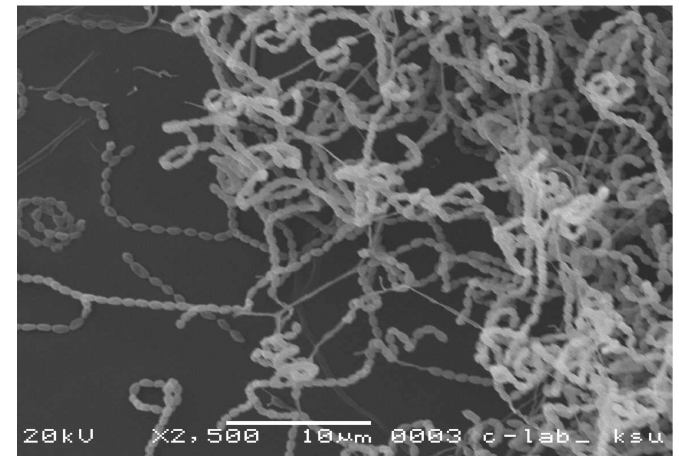
Figure 1. Scanning electron micrograph of actinomycete isolate 2 as a representative photo of the Streptomyces isolates used in this study (2500 × ).